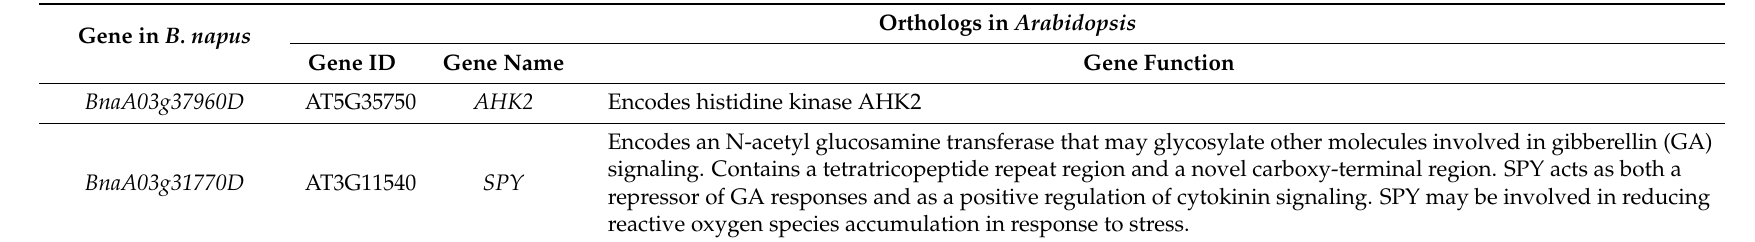
Table 6. The candidate genes BnaA03g37960D and BnaA03g31770D and their orthologs in Arabidopsis . Gene in B. napus